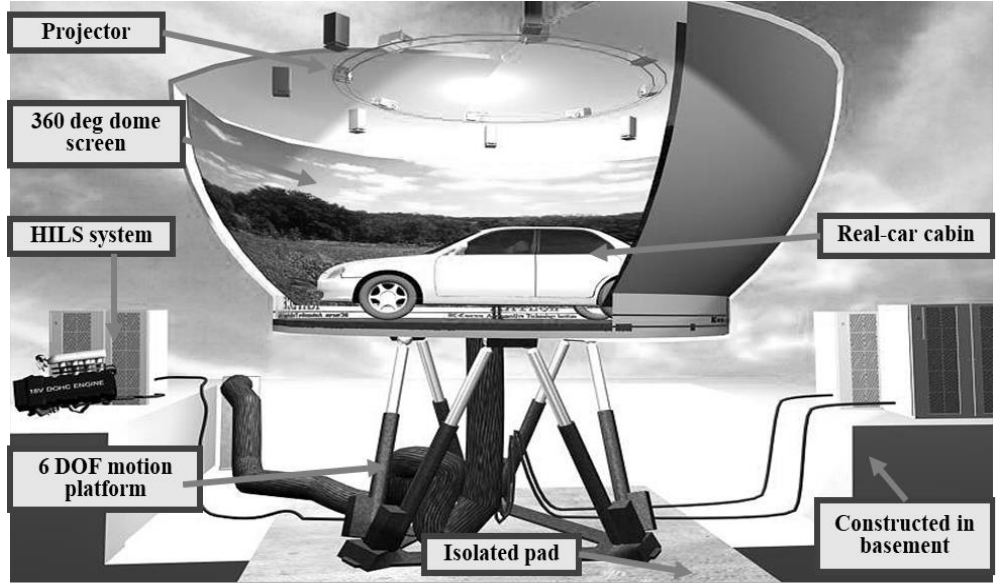
Figure 6. KATECH advanced automotive